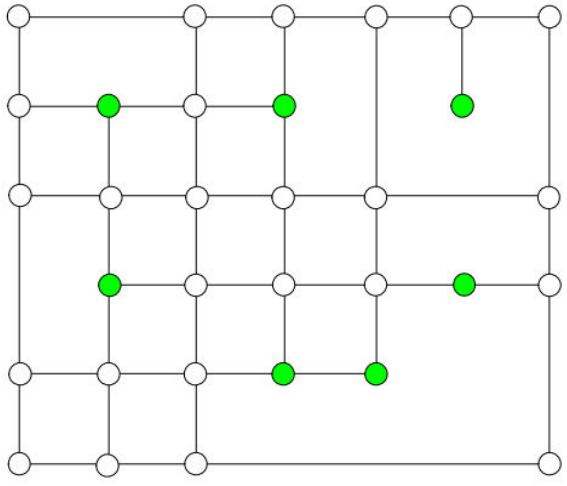
Figure 1. Topological structure of a